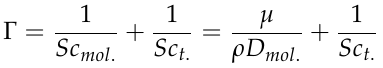
Figure 14. Percentage of total volume occupied with at least 95% of the final tracer concentration ( a ) and the average relative difference in mean tracer concentration within those volumes ( b ) for 60, 80, and 100 rpm. The blue dashed line locates a 95% volume occupation. From Figure 14, 𝜃 (cid:2877)(cid:2873) % can be determined as 47, 26, and 16 s for 60, 80, and 100 rpm, respectively, as indicated by the data surpassing the 95% volume occupancy. For these cases, the relative differences at 𝜃 (cid:2877)(cid:2873) % were 1.76, 1.61, and 1.31%, respectively, suggesting that the contents can be considered sufficiently homogeneous for mixing applications. Based on the results of Figures 13 and 14, it is observed that proper mixing in this configuration can be achieved when there is sufficiently vertical homogenisation. This is expected, as the surface vortex and the use of the RT promote circular and radial disper- sion, but not as much for axial dispersion. This suggests the use of other types of impellers that could promote axial mixing (if sufficiently high-mass transfer values can be ensured at reasonable power consumptions). However, it is also noted that H 2 entrainment would